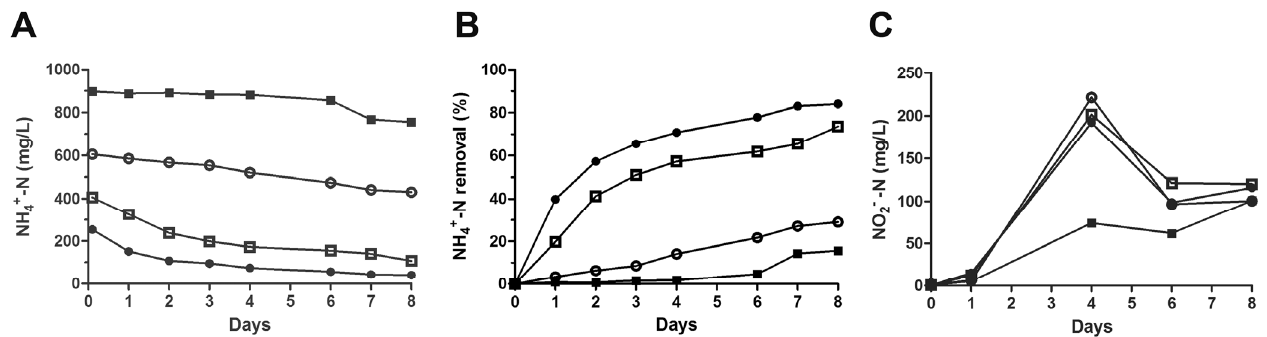
Figure 2. Effects of ammonia stress on NH 4+ removal rate by the activated sludge. Aliquots (10 mL) of the activated sludge (150 mg, dry weight) were mixed with 20 mL of LMM and incubated at 28 °C. Increasing ammonium concentrations, expressed as NH 4+ -N, were adjusted in the four cultures to 250 ( ● ), 400 ( □ ), 600 ( ◌ ) and 900 ( ● ) mg/L and monitored, using Nessler’s test, as a function of time ( A ) and reported as removal percentage ( B ). Nitrite concentration, expressed as NO 2 − -N, is reported ( C ). Data represent the average of three independent experiments and the standard devi- ation is ~10%.